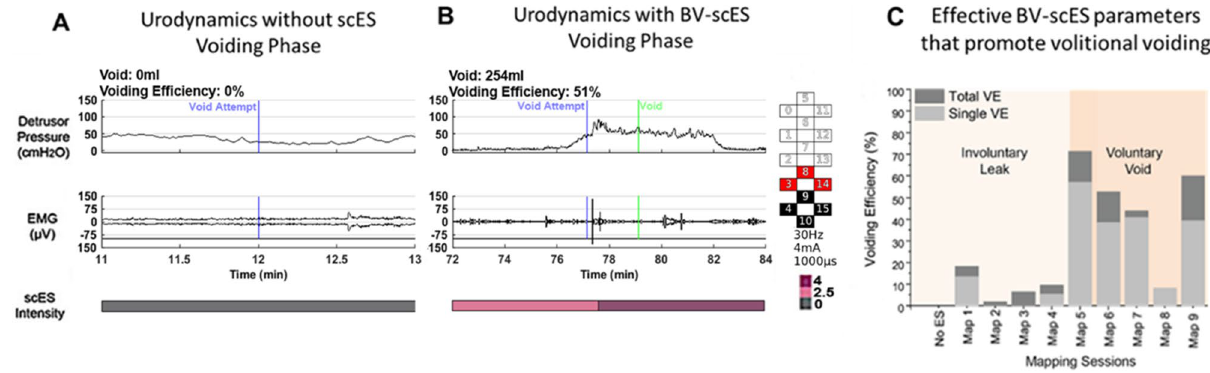
Figure 4. Improvement in ability to initiate bladder voiding with targeted BV-scES. Example of detrusor pressure (upper panel) and sphincter EMG (µv, lower panel) in the absence of scES ( A ) in an individual with chronic SCI (B07) (Leak: 0 mL; Capacity: 622 mL); ( B ) Representative cystometry recording in the same individual using BV-scES and parameters adjusted for void initiation (VE: 51.2%, Capacity: 496 mL); Voiding initiation was intensity (pink bar) dependent and participant-specific. Note the rise in detrusor pressure timed with relaxation of sphincter EMG activity and a return of detrusor pressure to baseline. ( C ) Effective and non-effective BV-scES parameters for promoting volitional voiding during urodynamics mapping sessions for B07. Initiating a void occurred only in the presence of optimized BV-scES. Reflexive leaks are indicated as involuntary. Light gray indicates the voiding efficiency (VE) for a single leak/void and dark gray indicates total voiding efficiency for a mapping session when multiple void attempts were possible. Mapping sessions were approximately 1 week apart. VE = [Void Amount/Void + Residual] × 100; Electrodes in B: cathodes = black; anodes = red; inactive = white.